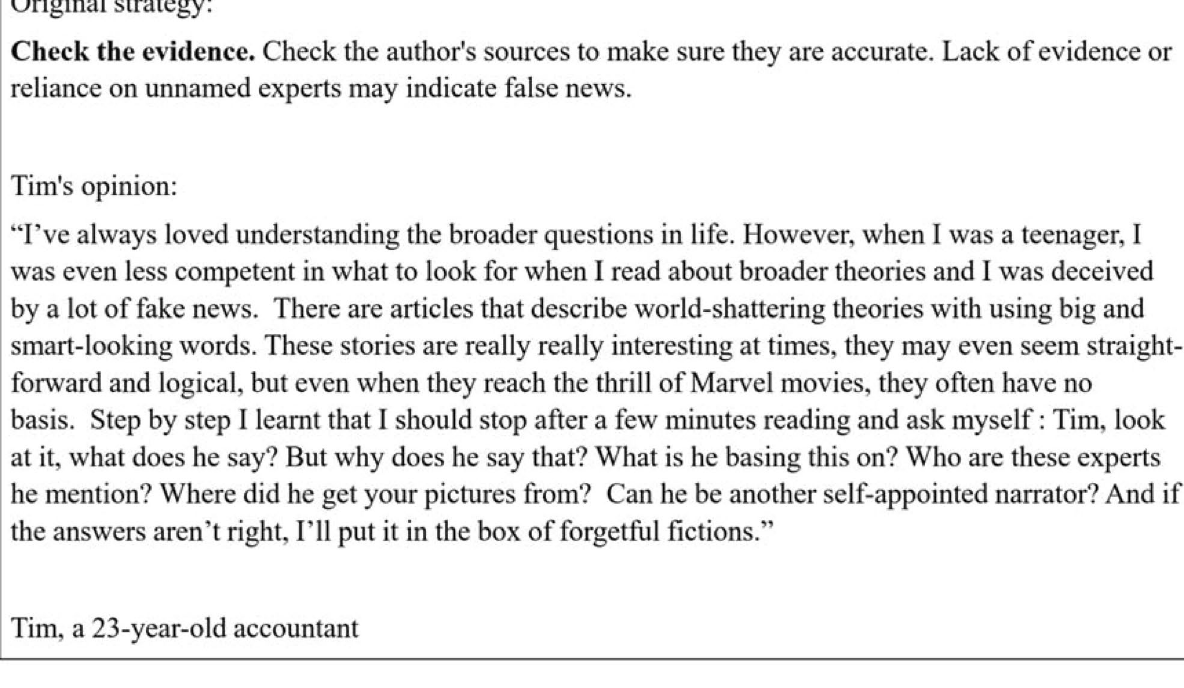
Figure 2. A testimonial explaining one of the six strategies. First, participants could read six testimonials explaining six